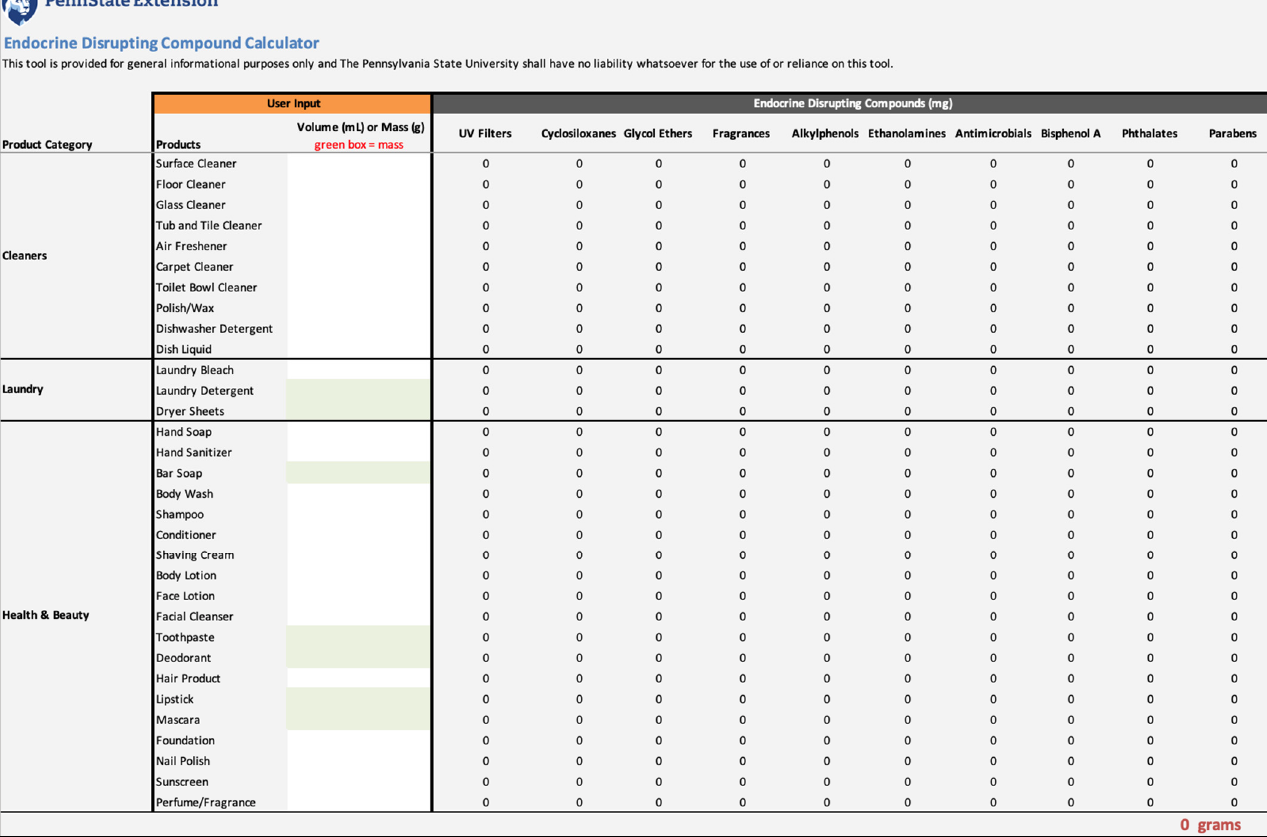
Figure 1. Endocrine-disrupting compound (EDC) footprint calculator user interface. User input is accepted in either volume (mL) or mass (g). The calculator then calculates and displays the estimated mass of EDCs in each product. The total EDC footprint for all products entered by the user is displayed in red on the bottom right side of the tool’s interface.